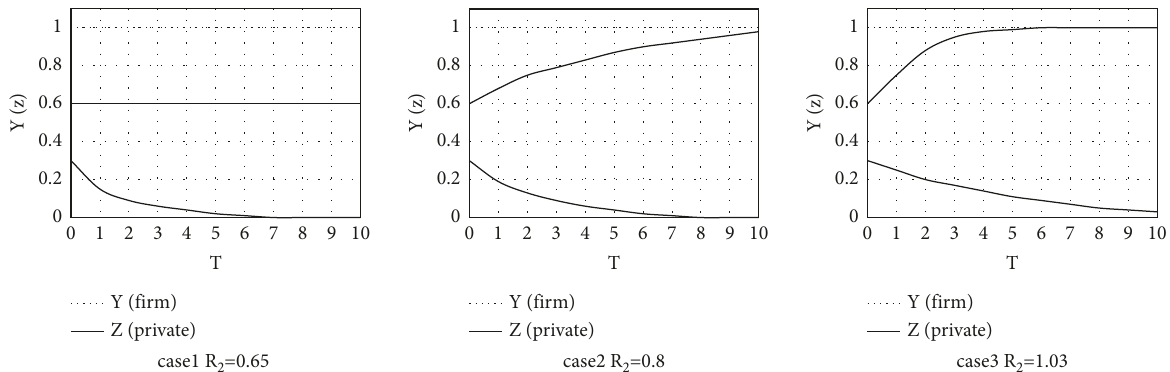
Figure 8: R 2 impact of changes on the evolution of co-created